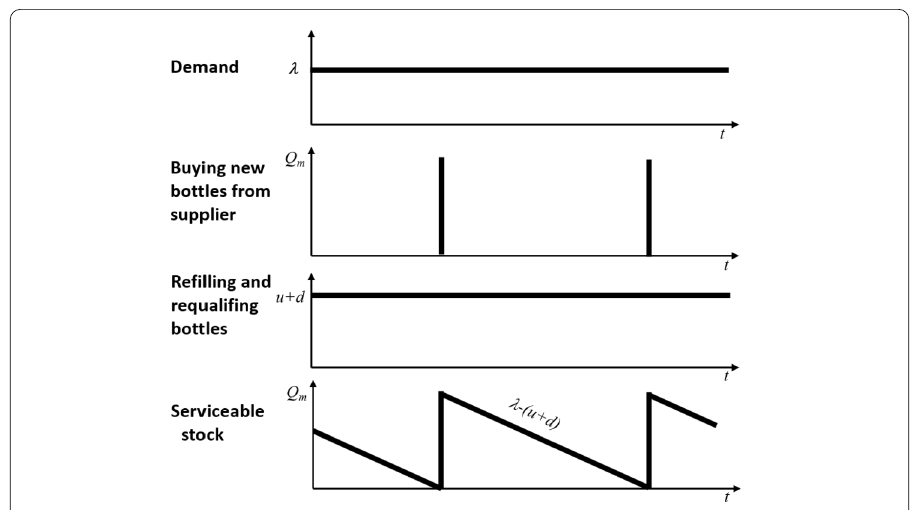
Approximately 40% of the total cylinders of the company are acquired. Returned and acquired cylinders are filled (with costs C f and go to operational stock, in order to meet the demand ( λ